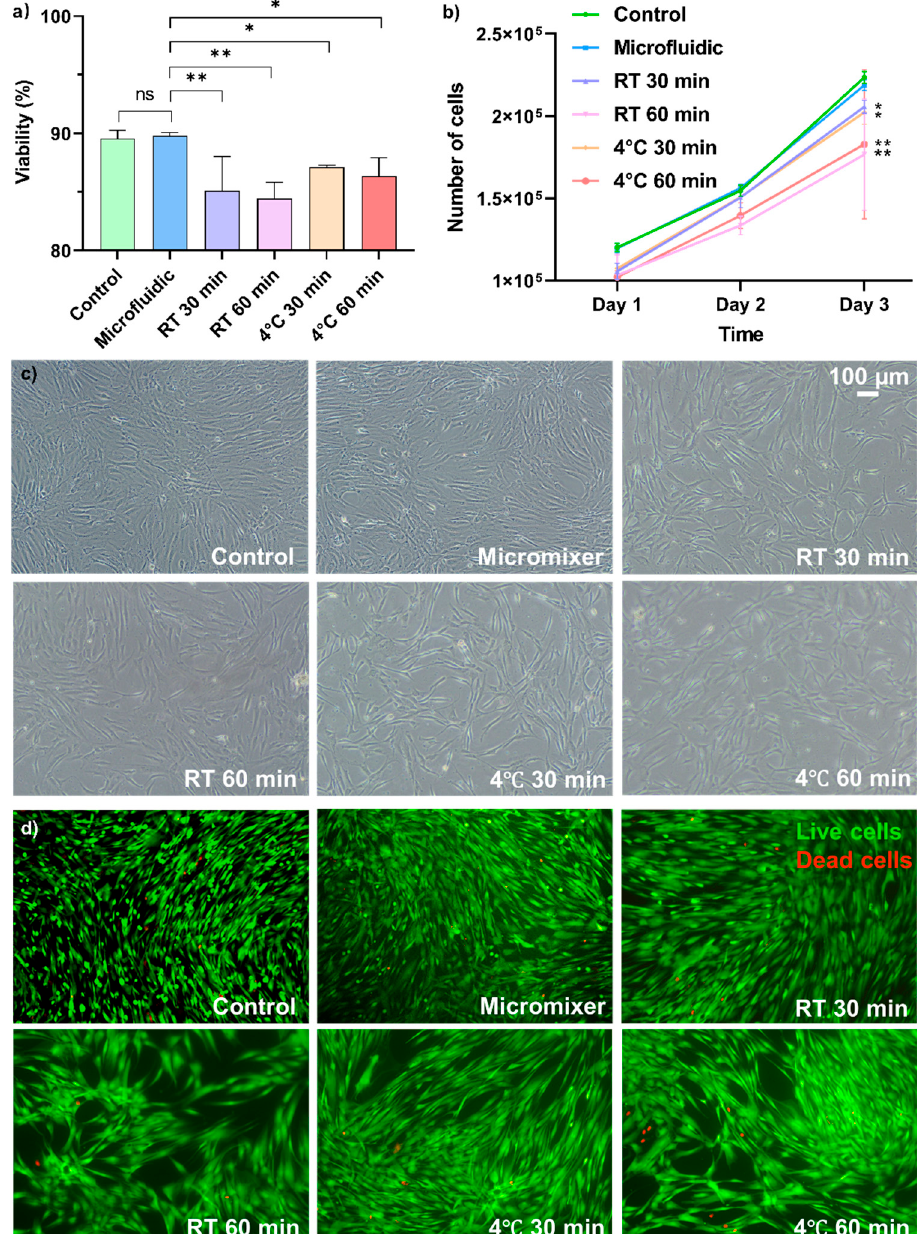
Figure 4. Cell viability and proliferation rate after exposing cells to DMSO under different conditions before cryopreservation. ( a ) Post-thaw viability of cells in different groups. Viability of each group is: 89.79 ± 0.28% for the microfluidic group, 89.55 ± 0.69% for the instant mixing control group, 85.10 ± 2.92% and 84.44 ± 1.38% for the RT 30- and 60-min groups, and 87.09 ± 0.19%, 86.35 ± 1.56% for the 4 °C 30- and 60-min groups. * indicates the significance between groups and n.s. indicates non significant. ( b ) Growth rate of cells after seeding them in 6-well plates for 3 days; the micromixer and instantly preserved control groups had a significantly higher growth rate than the other groups ( p < 0.001). ( c ) Cell morphology and ( d ) live and dead staining in 6-well plates on day 3 show mixing the cells and CPA in the micromixer does not damage the cell viability, morphology, and